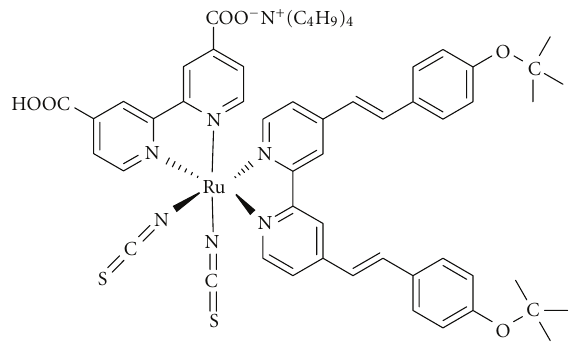
Figure 18: Molecular structure of the K77 sensitizer (taken from